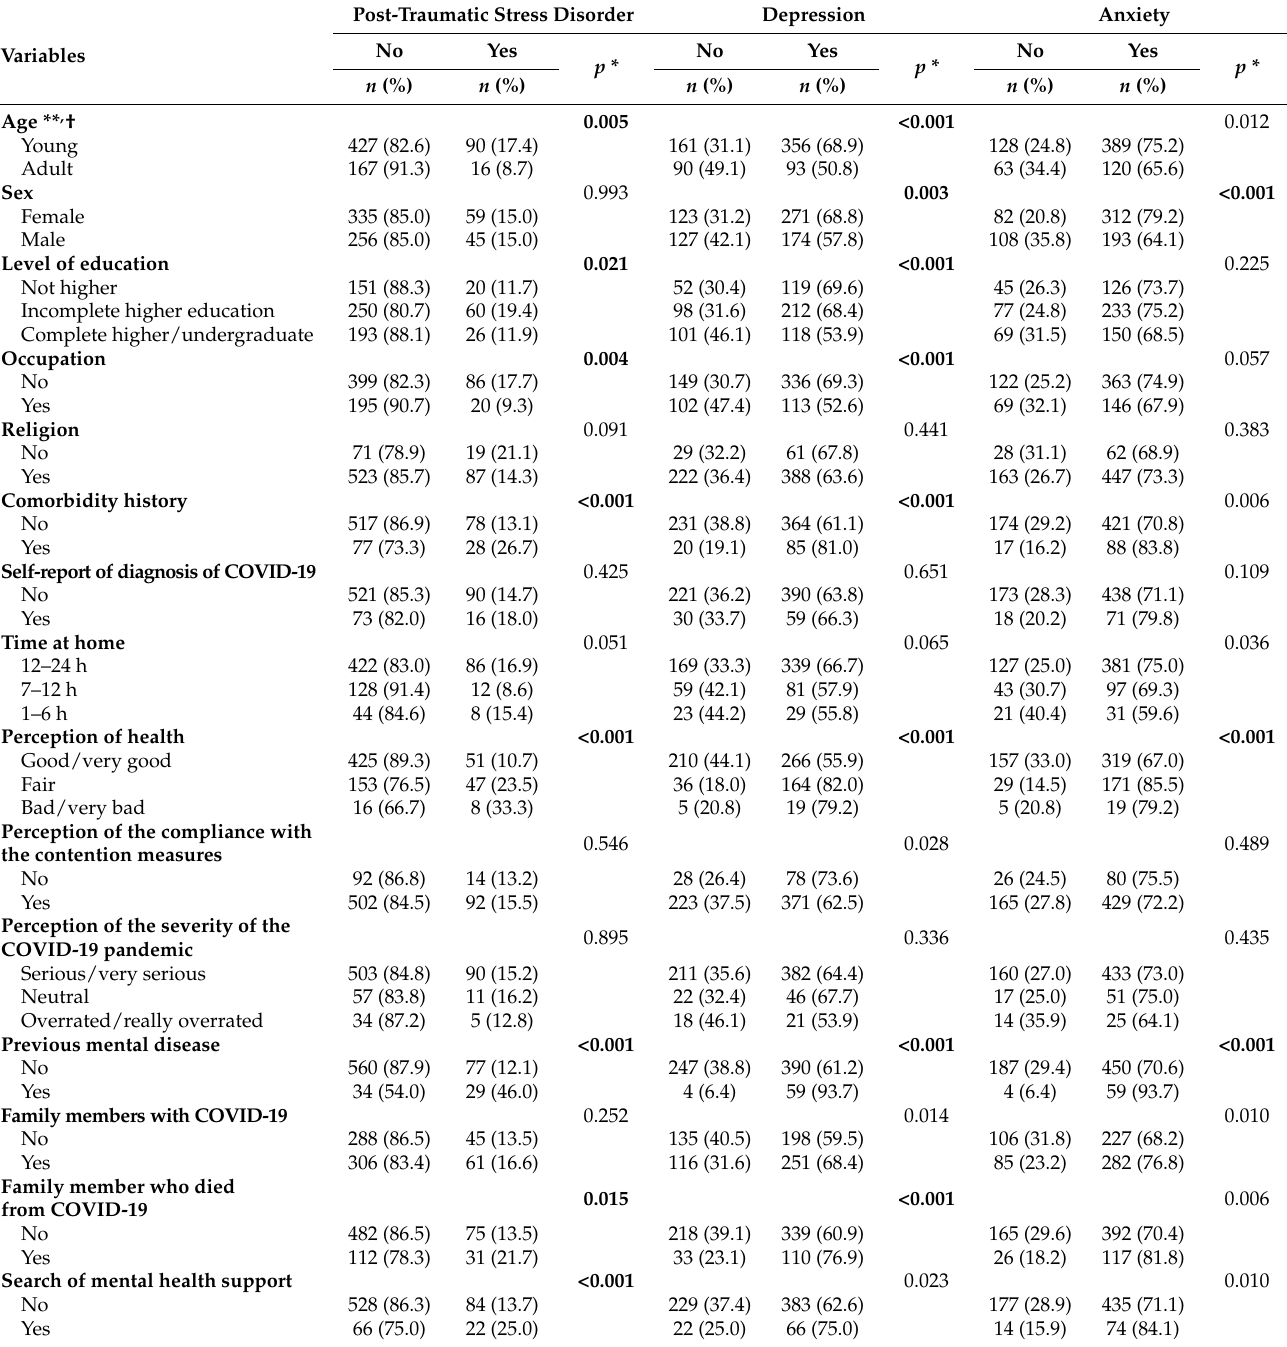
Table 2. Factors associated with post-traumatic stress, depression, and